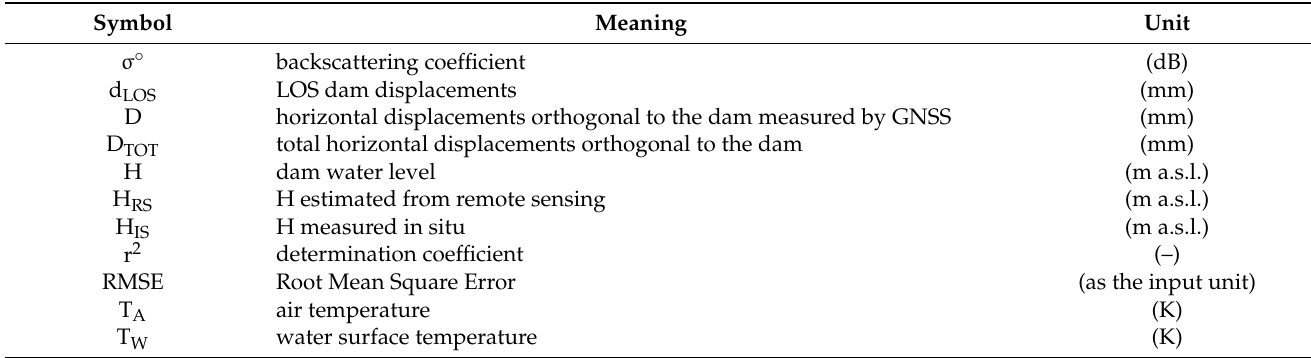
Table A2. Symbols